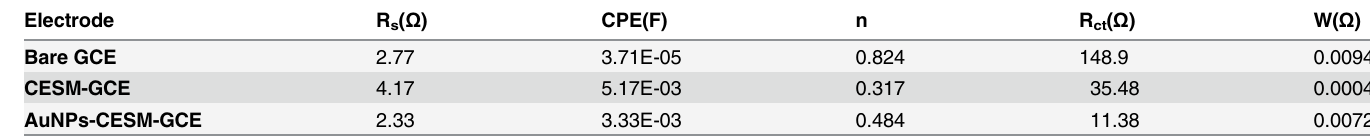
Table 2. EIS data of different modified electrodes in 1 mM [Fe(CN) 6 ] 3-/4- .